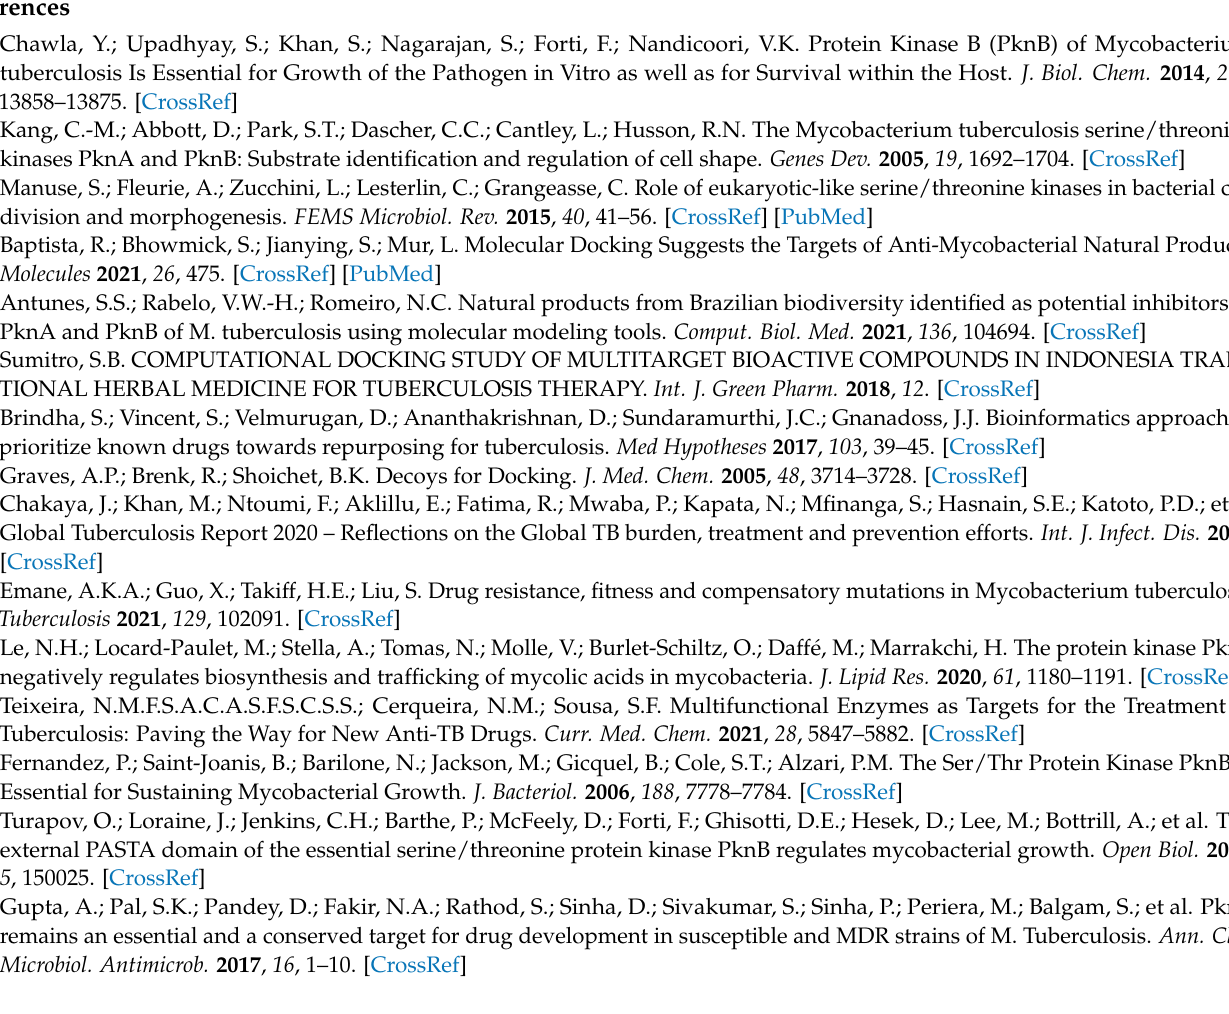
a better affinity, Table S3: ASP score results for all the molecular targets studied. A higher score corresponds to a better affinity, Table S4: ChemScore score results for all the molecular targets studied. A higher score corresponds to a better affinity, Table S5: GoldScore score results for all the molecular targets studied. A higher score corresponds to a better affinity, Table S6: Vina score results for all the molecular targets studied. A more negative score corresponds to a better